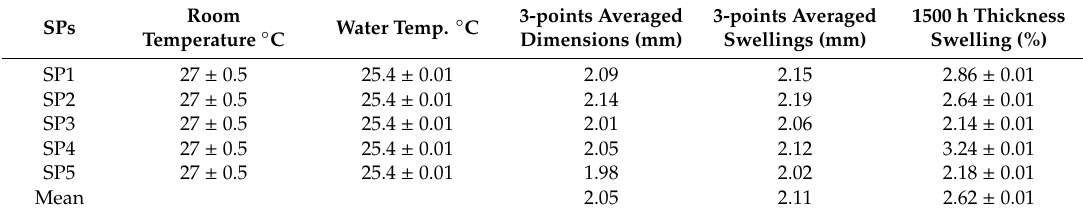
Figure 8. Cross-sectional SEM image of immersed composites. ( a , b ) Two cross-sectional views from the first perspective. ( c , d ) Two cross-sectional views from the second perspective. ( 1 ) Void, ( 2 ) fiber matrix debonding, ( 3 ) matrix disarrangement, ( 4 ) porosity, ( 5 ) good surface adhesion, ( 6 ) good matrix bonding.